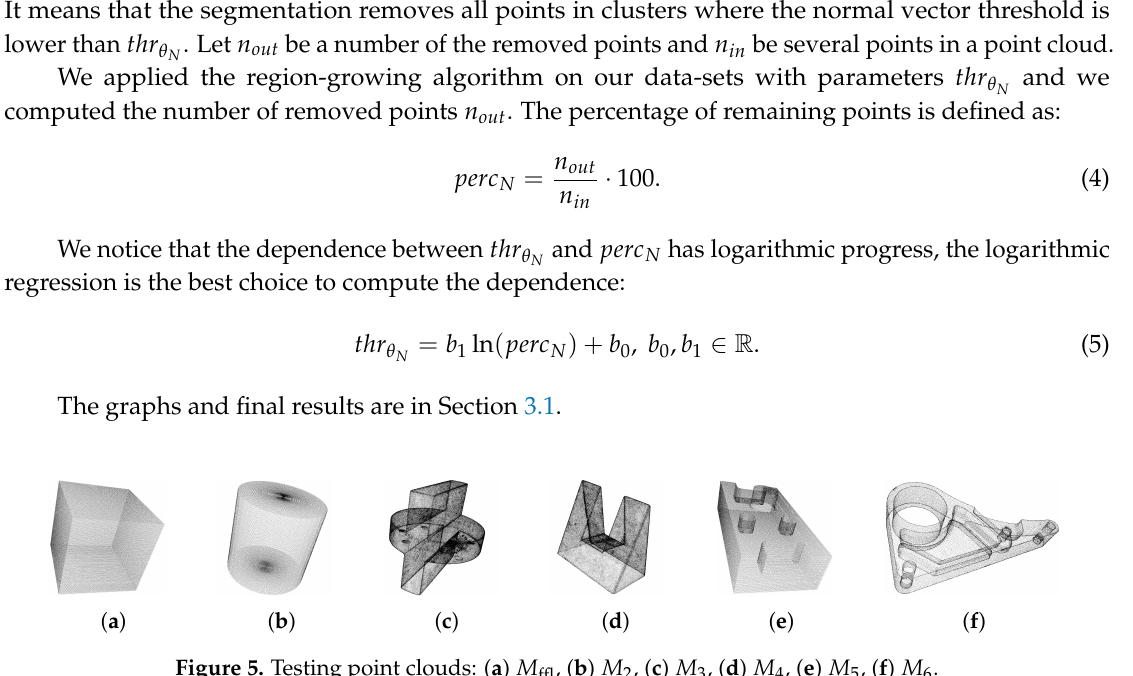
Figure 5. Testing point clouds: ( a ) M ffl , ( b ) M 2 , ( c ) M 3 , ( d ) M 4 , ( e ) M 5 , ( f ) M 6